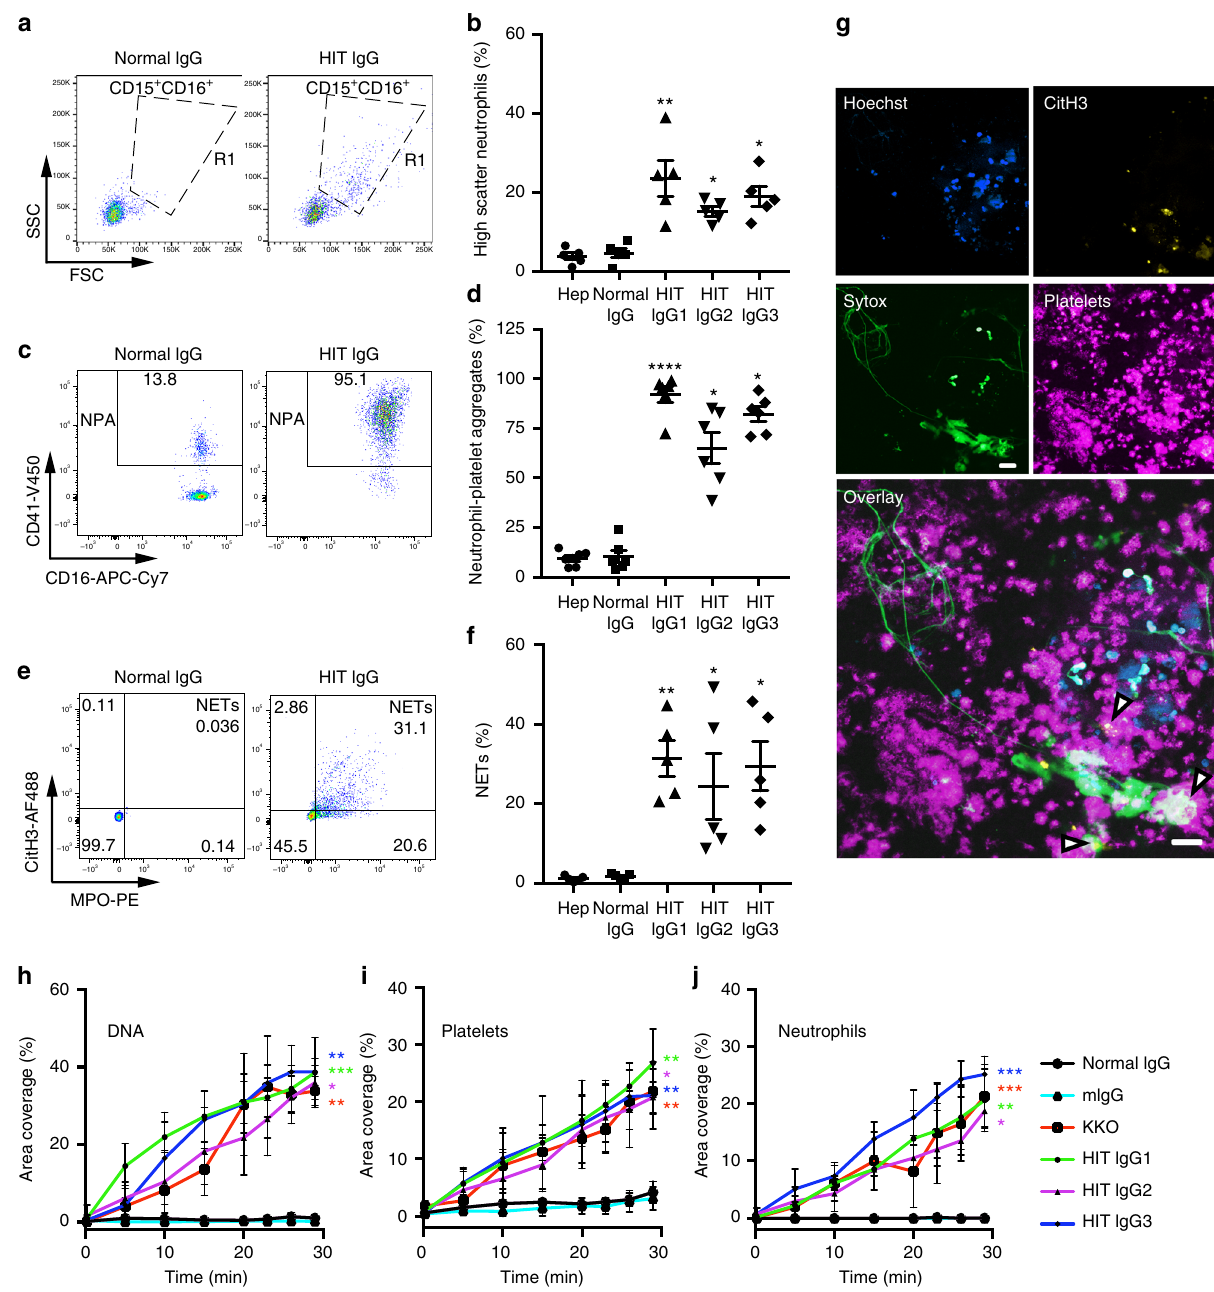
Fig. 2 HIT patients ’ IgG induces NETosis. a Representative fl ow cytometry density plots of side scatter (SSC) versus forward scatter (FSC) backgated for neutrophils (CD15 + CD16 + population). b Quanti fi cation of high-scatter neutrophils using IgG from three HIT patients repeated with blood from different healthy donors ( n = 5). c Neutrophil – platelet aggregates (NPA) induced in whole blood by HIT IgG in the presence of heparin (0.5 U/ml), and ( d ) quanti fi cation of NPA using IgG from three HIT patients repeated with blood from different healthy donors ( n = 6). e Representative fl ow cytometry scatter plots of NETs induced in whole blood by HIT IgG plus heparin. The numbers in the quadrants indicate percentage of gated events. f Quanti fi cation of NETs using IgG from three HIT patients with blood from different healthy donors ( n = 5). g Citrullinated histone H3 is present in HIT IgG-induced thrombi ex vivo. DNA in nucleated cells was stained with Hoechst 33342 (blue), extracellular DNA with Sytox green (green), CitH3 with anti-CitH3 Alexa 594 (yellow) and platelets with anti-CD41 Alexa 647 (magenta). White areas indicate superposition of signals. White arrowheads indicate areas of CitH3 staining. Images were taken with a confocal laser-scanning microscope (Leica TCS SP8) with a ×40 water immersion objective running Leica ’ s LAS X software. Scale bar: 20 μ m. h – j Graphs represent percentage area coverage of VWF-coated surfaces versus time for ( h ) the extracellular DNA (Sytox + areas), ( i ) platelets (CD41 + ) and ( j ) neutrophils (CD15 + ). Percentage coverage area determinations were calculated for the times indicated. Mean± s.d are shown; n = 3. Statistical analyses, for ( b , d , f ) Kruskal – Wallis test followed by Holm ’ s Stepdown Bonferroni procedure for adjusted p -values. Data are expressed as mean ± s.e.m. For ( h , i , j ), one-way ANOVA relative to normal IgG with Dunnett ’ s post-test. * P < 0.05; ** P < 0.01; *** P < 0.001 relative to normal IgG. Mean± s.d. are shown. Source data for ( b , d , f , h , i , j ) are provided as a Source Data fi le